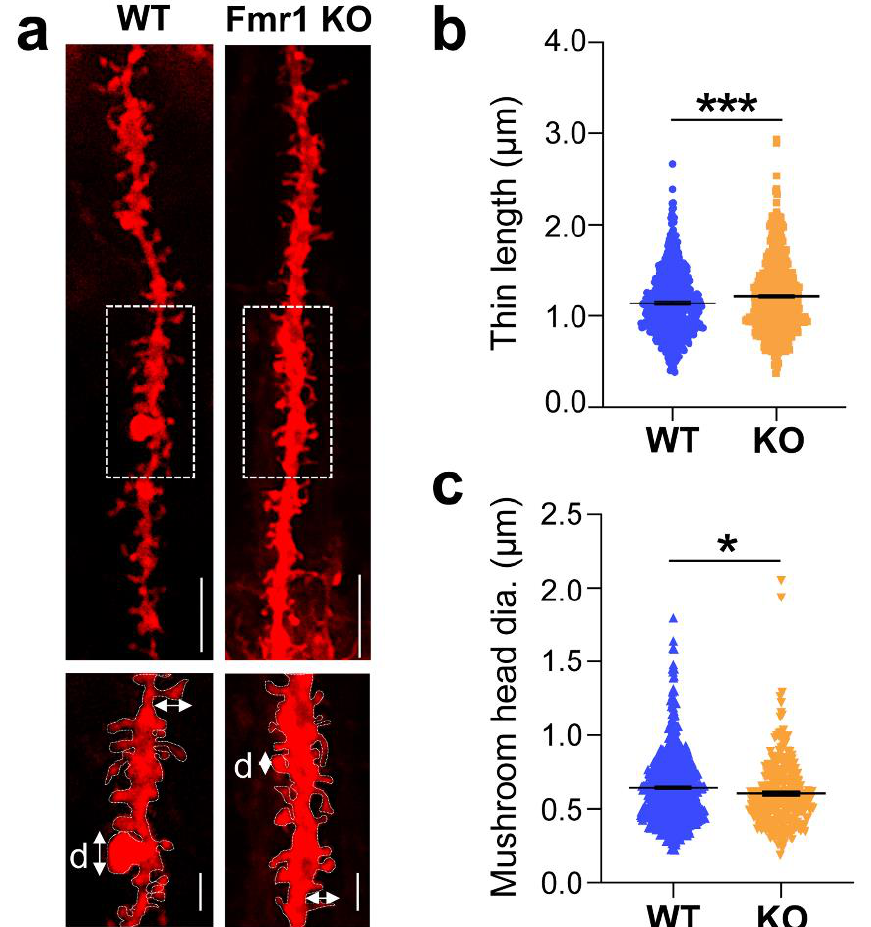
Figure 4. Morphological alterations of thin and mushroom spines in the Fmr1 KO mouse hippocam- pus. ( a ) Representative confocal images of dendritic branches stained with DiIC 18 from WT and Fmr1 KO hippocampi; scale bars, 5 µ m. Boxed regions are displayed in magnified insets below; scale bars, 2 µ m. Arrows indicate the length and head width measurements; d, diameter of spine heads. ( b ) Quantification of the length of thin spines in WT and Fmr1 KO littermates. ( c ) Quantification of mushroom spines head width (diameter) in WT and Fmr1 KO mice. Differences were evaluated by Student’s t -test * p = 0.018, *** p < 0.0008, N = 3 mice per